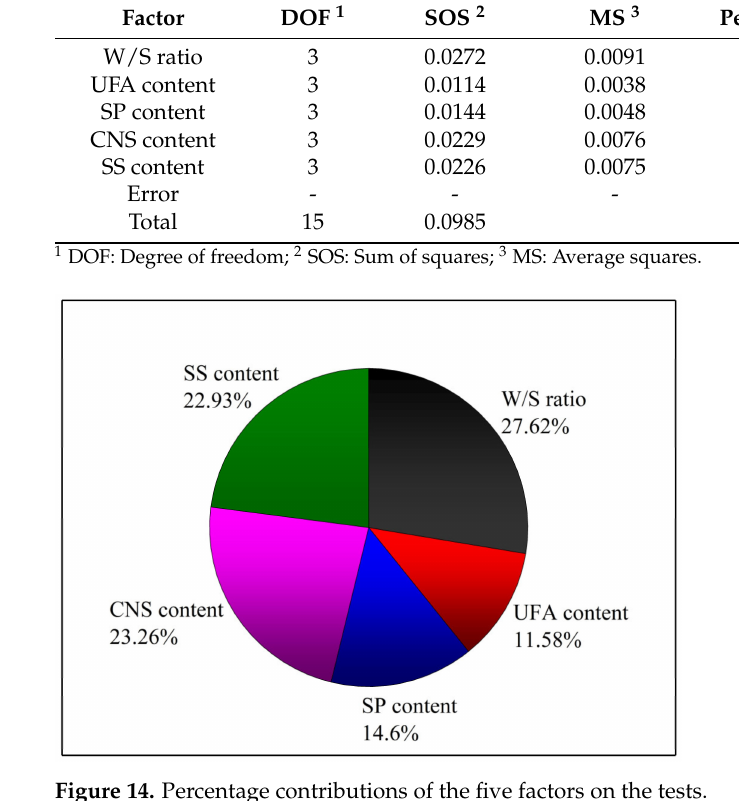
Figure 14. Percentage contributions of the five factors on the